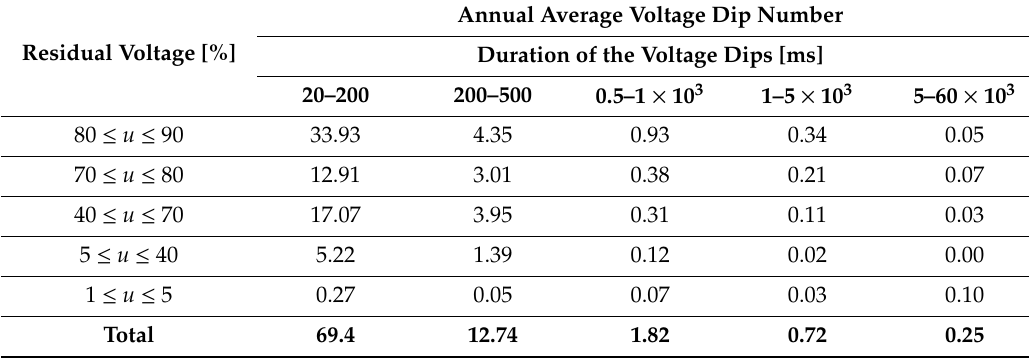
Table 1. Annual Average Voltage Dip Number for MV substations connected to the Italian National Grid (data taken from